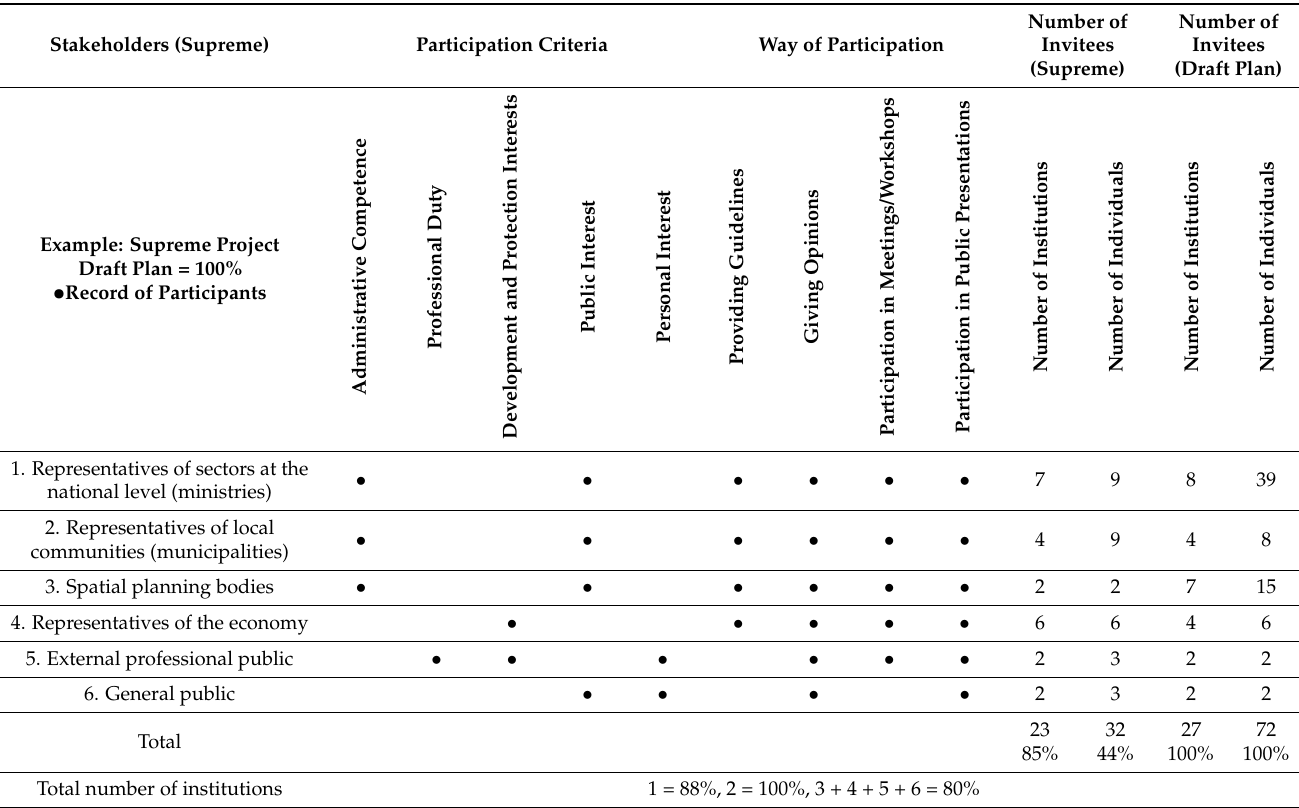
Table 6. Detailed analysis of the participating stakeholders in the SUPREME project, prepared based on the minutes of the workshops, working, and coordination meetings and the final report.